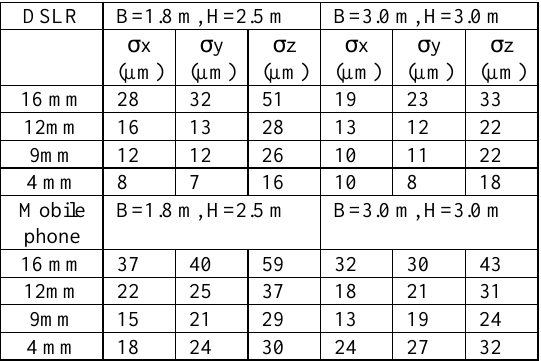
Table 7: RMSE of photogrammetric